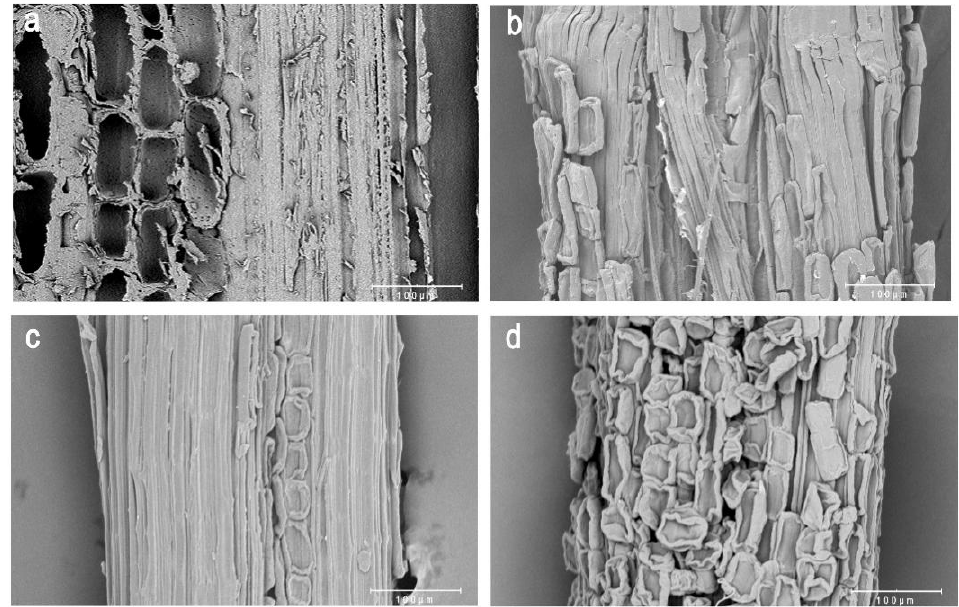
Figure 1. SEM images of natural bamboo ( a ) and bamboo fibers with three different delignification methods ( b − d ). ( b ) Peroxyformic acid method; ( c ) acetic acid/dioxygen water method; ( d ) alkaline sodium sulfite method. Bar = 100 µm.